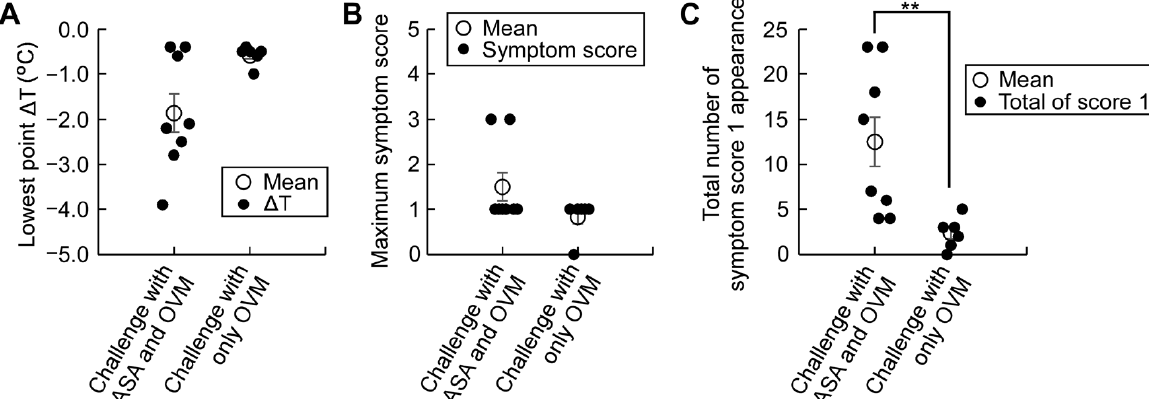
Figure 5. Effects of ASA pre-medication on the modified symptom score evaluation system after oral allergen challenge in sensitized mice. Allergic reactions after OVM challenge in sensitized mice were compared with and without ASA-pre-medication at 50 mg/kg. ( A ) Comparison of the effects on the lowest point ∆ T; ( B ) Comparison of the effects on the maximum symptom score; ( C ) Total number of recorded symptom score 1 after allergen challenge for 90 min. Data are mean ± SEMs. ( n = 6–8/group) ** p < 0.01.